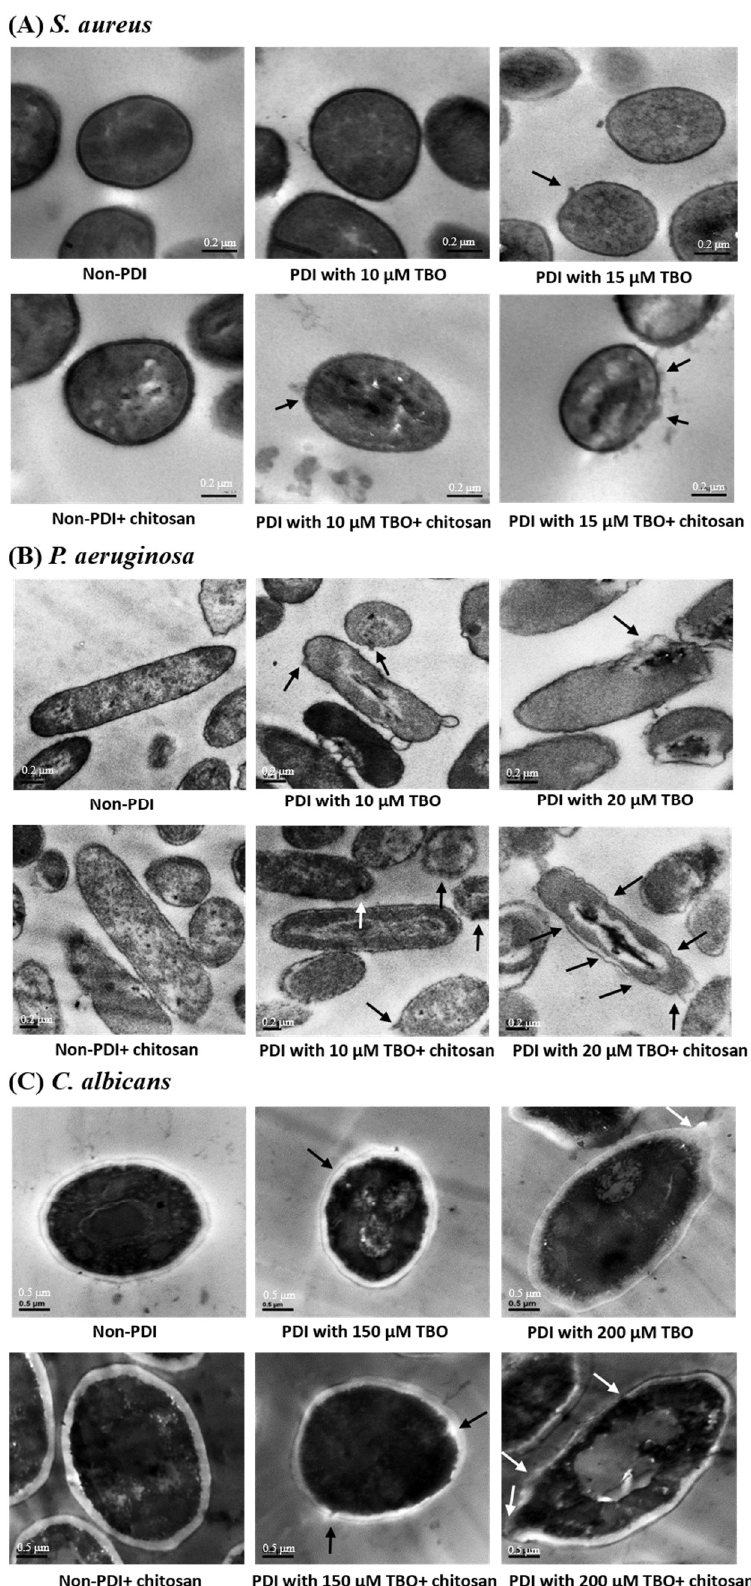
Figure 2. Transmission electron microscopy (TEM) showed that PDI combined with chitosan caused severe damage to the cell surface. Images of ( A ) S. aureus , ( B ) P. aeruginosa , and ( C ) C. albicans were taken after TBO-mediated PDI, chitosan, or combined treatment of PDI and chitosan. Arrows indicate irregular cell surfaces.